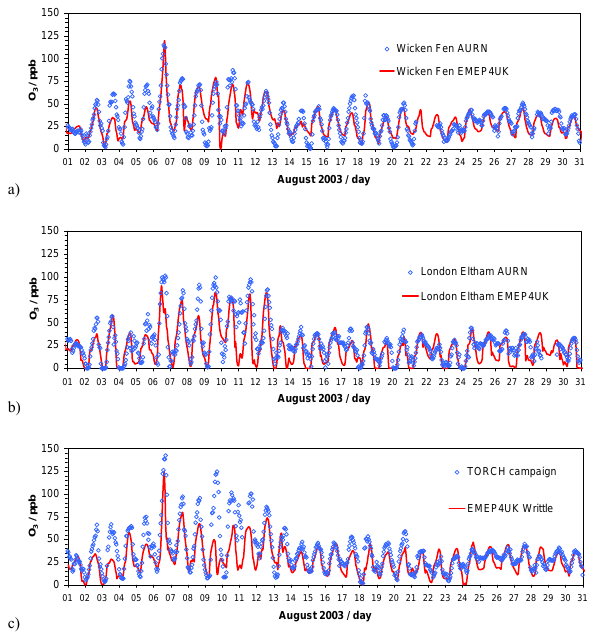
Fig. 4. Hourly time-series of modelled (red line) and measured (blue circles) surface ozone (ppb) during August 2003 at: (a) Wicken Fen, (b) London Eltham, and (c) TORCH campaign (Writtle).